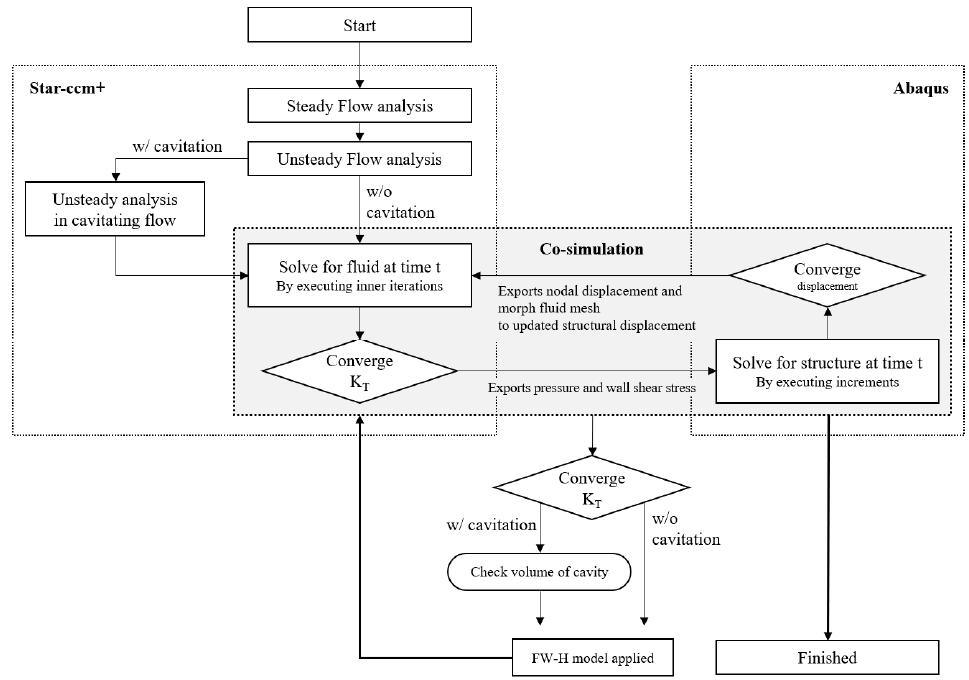
Figure 7. Flow Diagram for the coupled CFD-FEM fsi analysis.